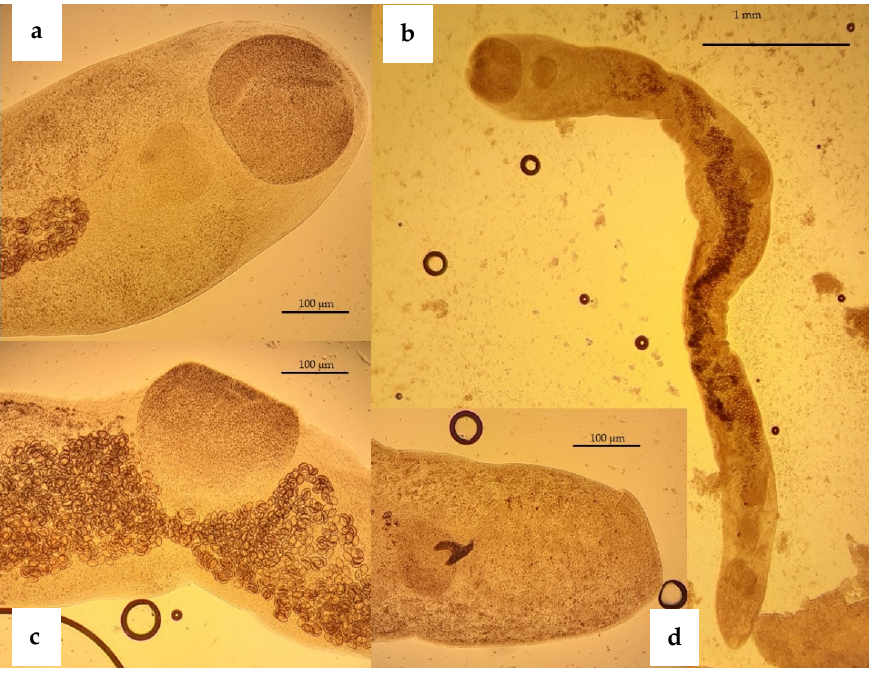
Figure 3. European hedgehog. Brachylaemus erinacei , adults isolated from the small intestine. ( a ) Oral sucker of 229.7 μ m in diameter, ( b ) adult specimen measuring 2.85 mm in length, ( c ) ventral sucker of 185.4 μ m in diameter and eggs measuring 32.18 μ m × 22.91 μ m and ( d ) caudal end with male and female gonads. Table 1. Identified parasites in European hedgehogs from central Italy ( n = 40), with respective prevalence ( p ) and 95% confidence interval (CI). A,B : p < 0.01. Males ( n =